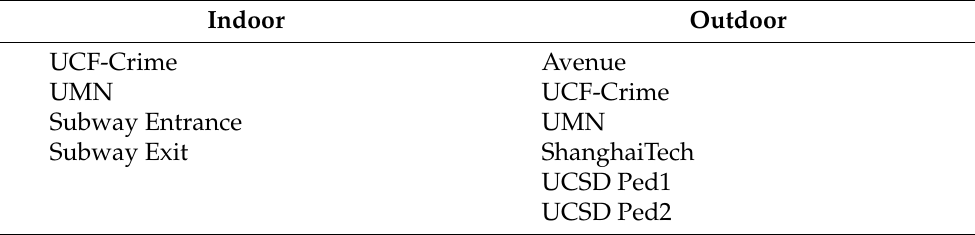
Table 11. Based on the recording environment.